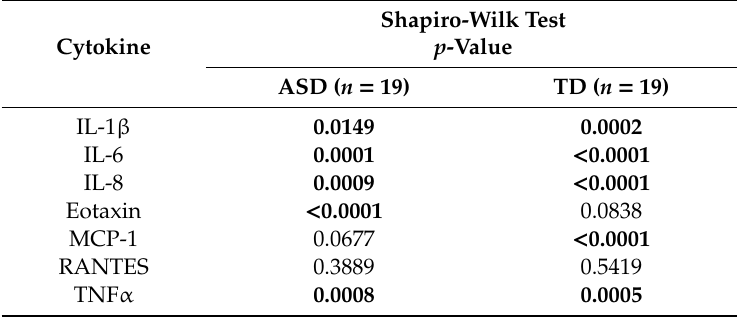
Table 1. Assessment of the normality distribution of variables.